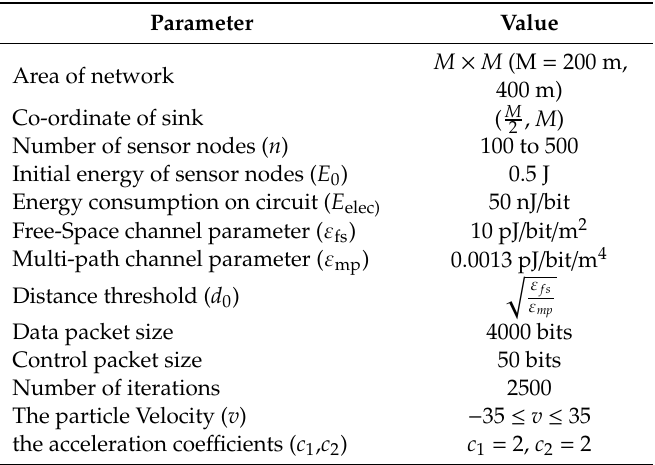
Table 1. Simulation parameters.